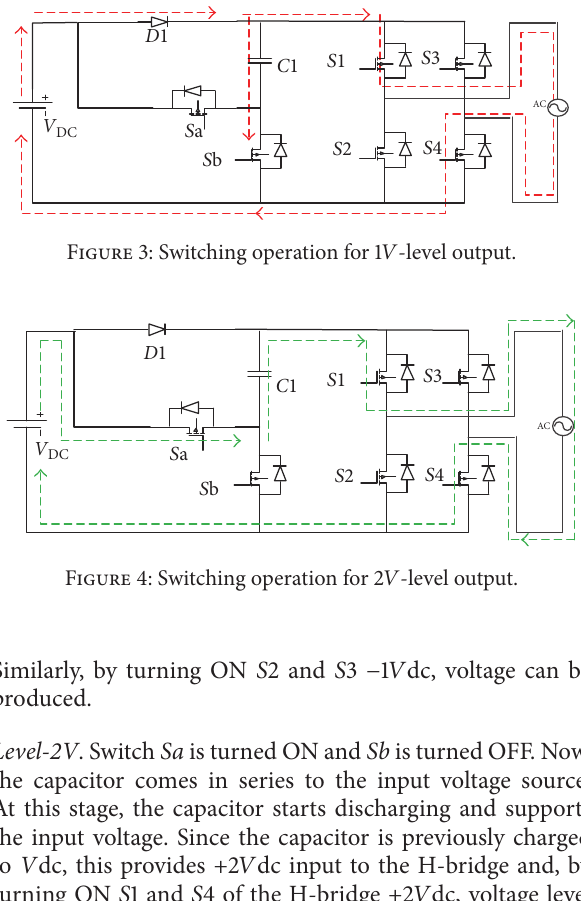
Similarly, by turning ON S 2 and S 3 − 1 𝑉 dc, voltage can be produced.